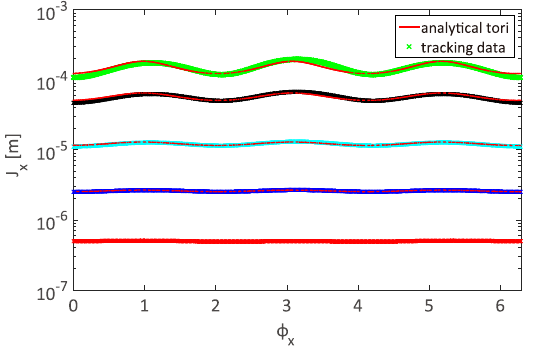
FIG. 3. Poincaré map showing the tracking data points of the particles in the horizontal normalized phase space ð X; P color denotes the phase-space trajectory of one particle.